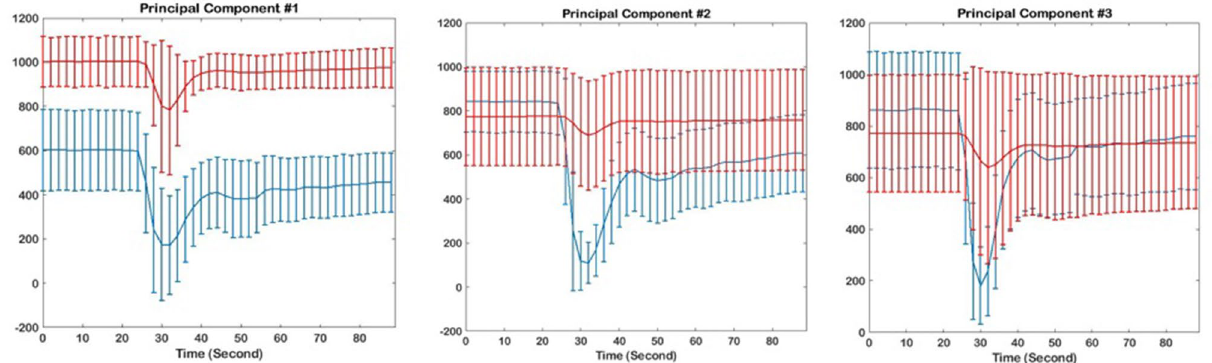
Figure 5. The perfusion curves calculated form the regions with highest (red) and lowest (blue) values on individual Principal Component images: (left) Principal Component 1; (middle) Principal Component 2; and (right) Principal Component